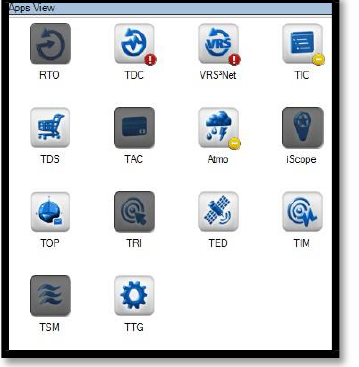
Figure 1.a: TUSAGA-Aktif